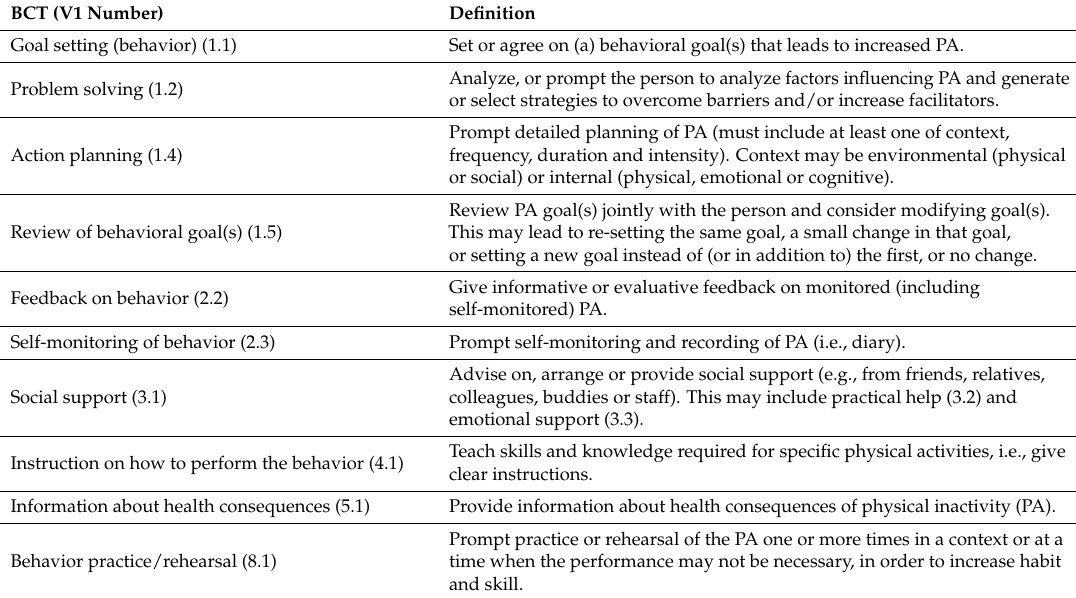
Table 1. Applied behavior change